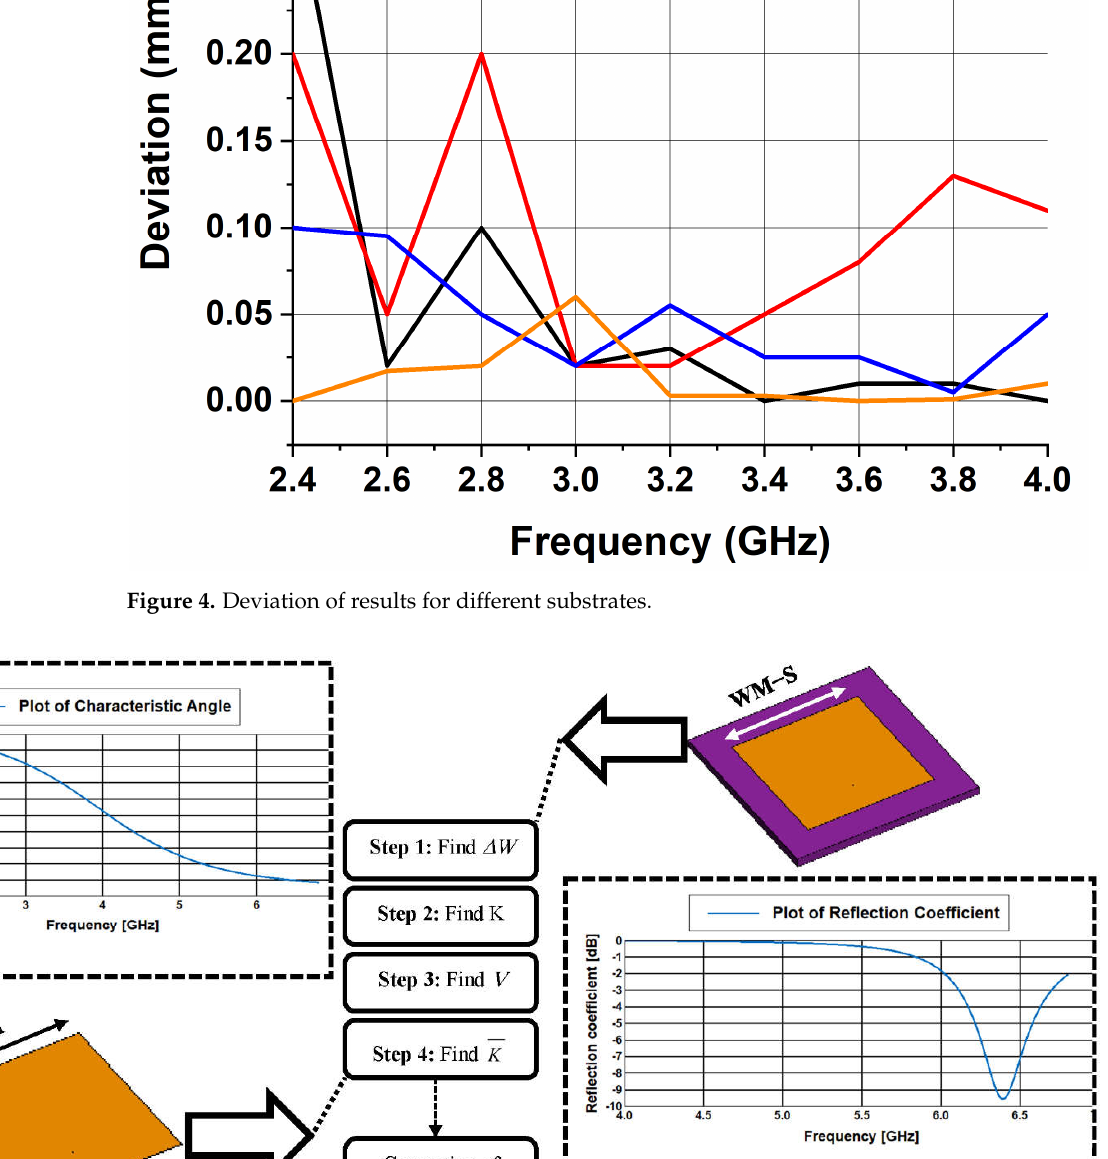
Figure 5. Summary of the formulation